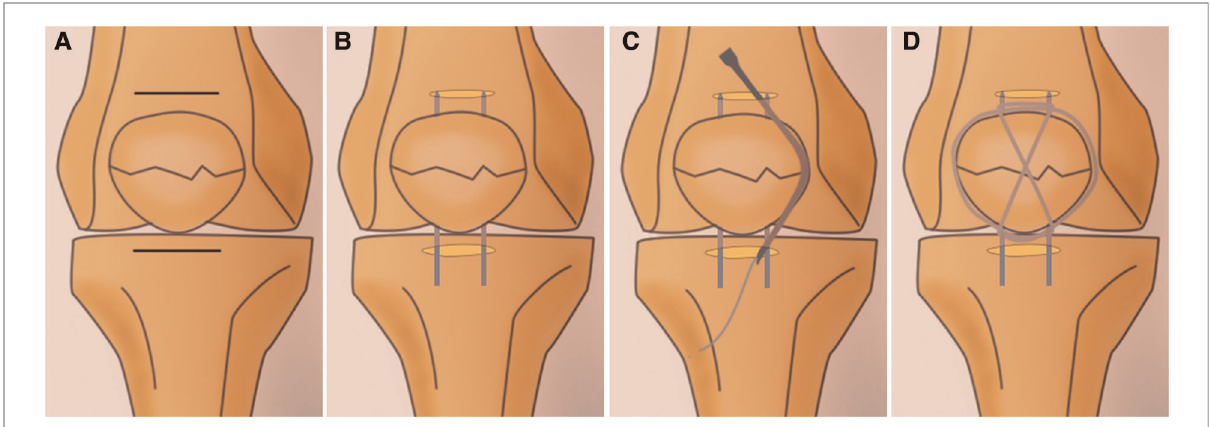
FIGURE 1 Diagrams show the main surgical procedures of the minimally invasive surgical technique. ( A ) Two paralleled incisions approximately one centimeter above and below the patella are made. ( B ) After a closed reduction of the fracture, two Kirschner wires are passed through the fracture fragments from the incision. ( C ) A wire passer or lumbar puncture needle is utilized to introduce the titanium cable subcutaneously. ( D ) The outcome of the fi